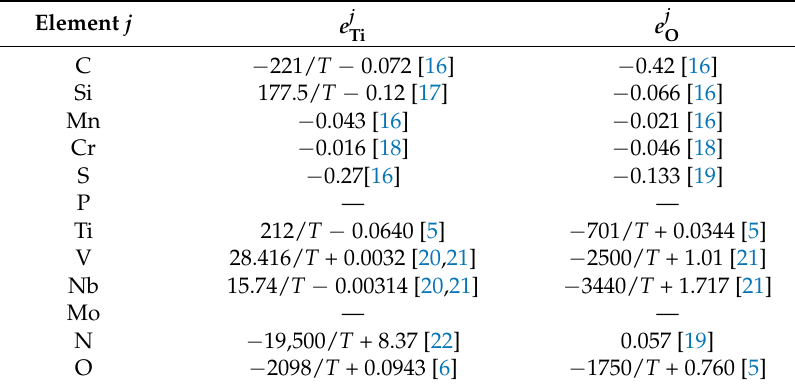
Table 2. Selected interaction activity coefficient in dilute solutions of